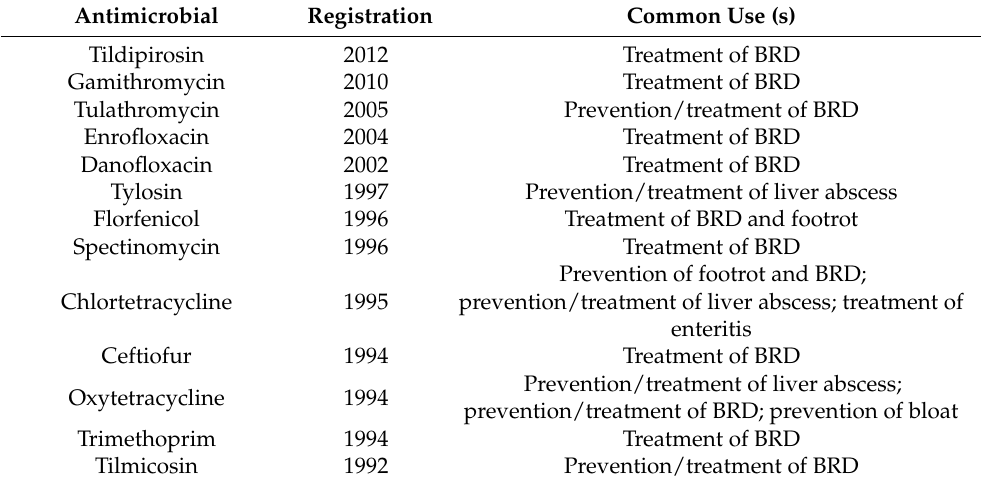
Table 2. Year of license approval for antimicrobials used in North American feedlot cattle for the prevention and treatment of bovine respiratory disease